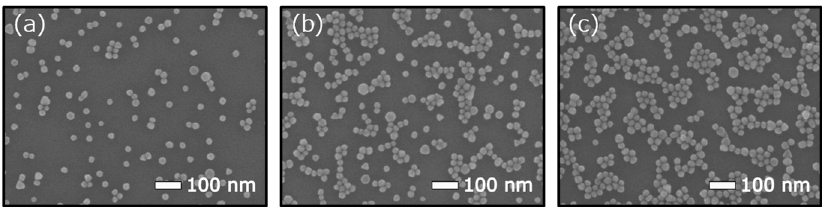
Figure 4. Representative SEM images of an EISCAP surface decorated with AOT-AuNPs with immobilization times of 0.5 h ( a ), 1 h ( b ) and 2 h ( c ).